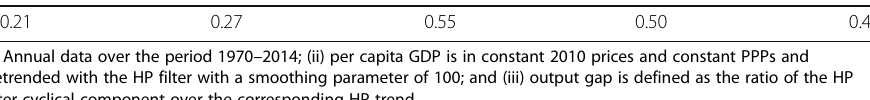
Table 14 A comparison of wages: the Greek power company ( Δ ΕΗ ) ΔΕΗ Public sector